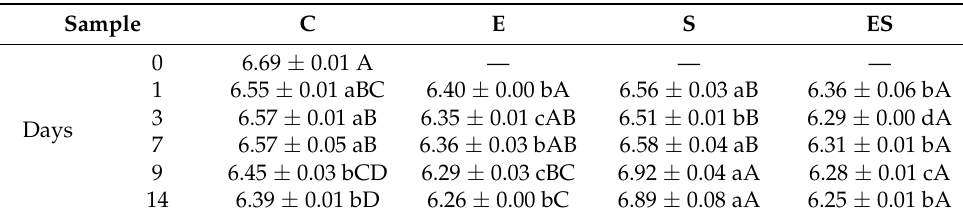
Table 11. pH in fish burgers for 14 days of storage: without inoculum (C); with 8% ethanol-water extract (E); with inoculum (S); and with 8% of extract and inoculum (ES). Sample C E S ES 0 6.69 ± 0.01 A — — — 1 6.55 ± 0.01 Days